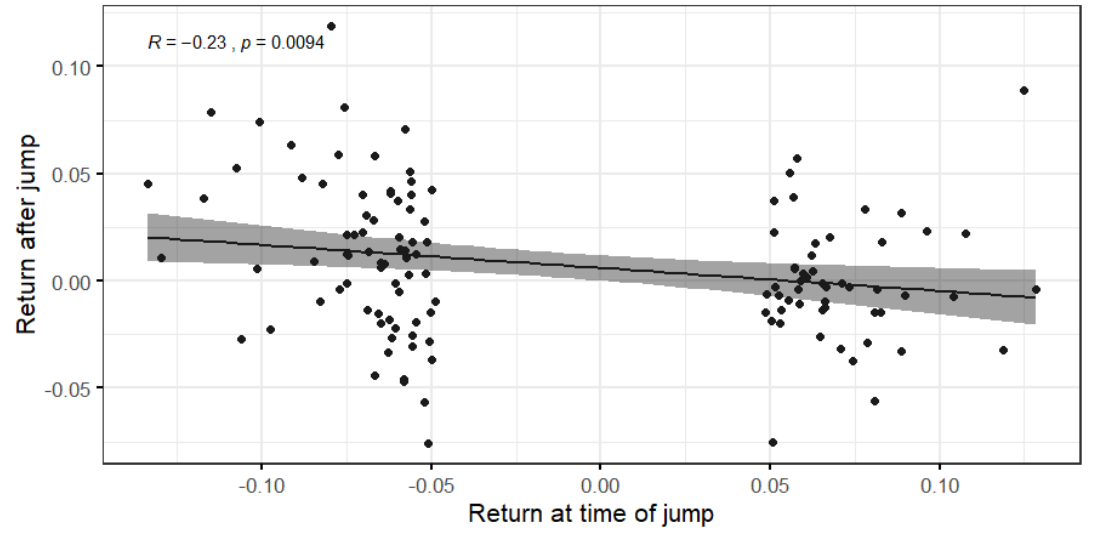
Fig. 9. Scatterplot of bi-hourly returns at and after jumps larger than or equal to 4 σ